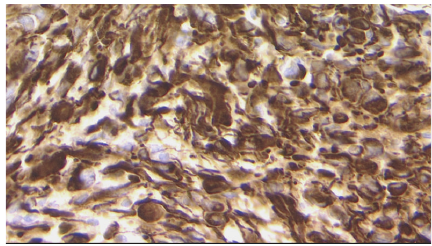
Figure 3: Photomicrograph demonstrating results of GFAP immunohistochemical staining. The neoplastic cells are strongly positive for GFAP immunostain. Original magnification ×